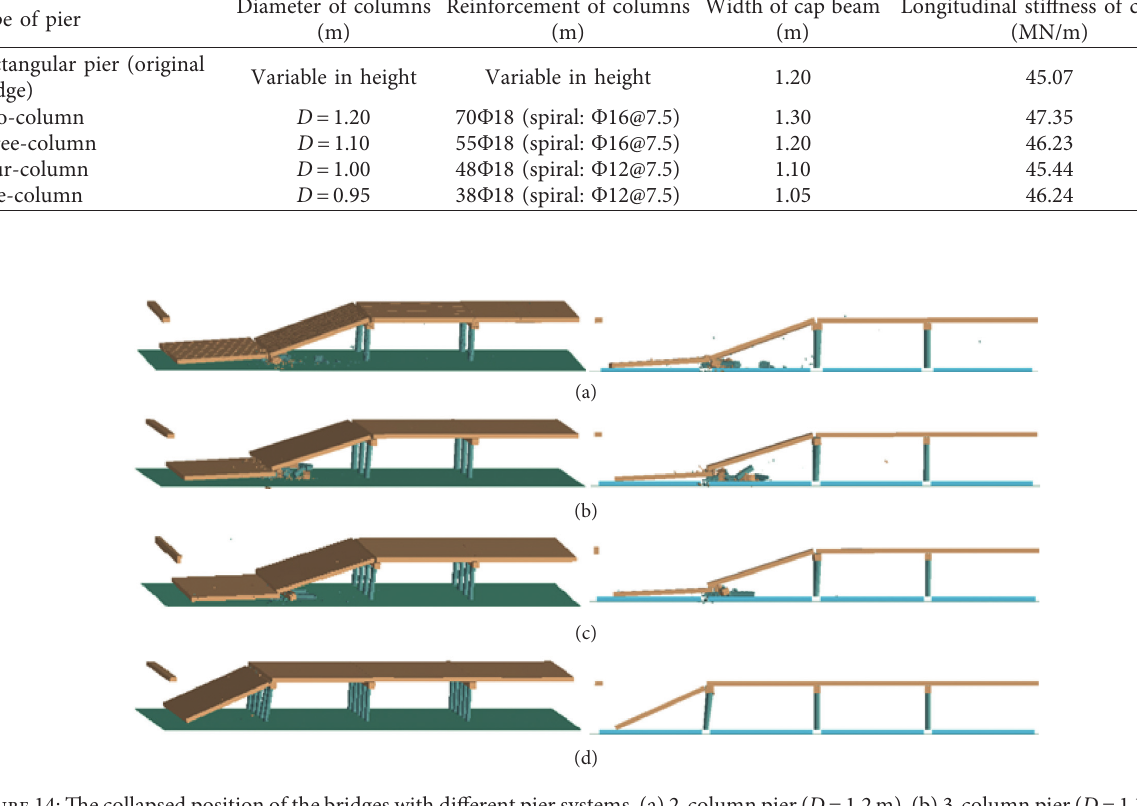
Figure 14: The collapsed position of the bridges with different pier systems. (a) 2-column pier ( D � 1.2m). (b) 3-column pier ( D � 1.1m). (c)